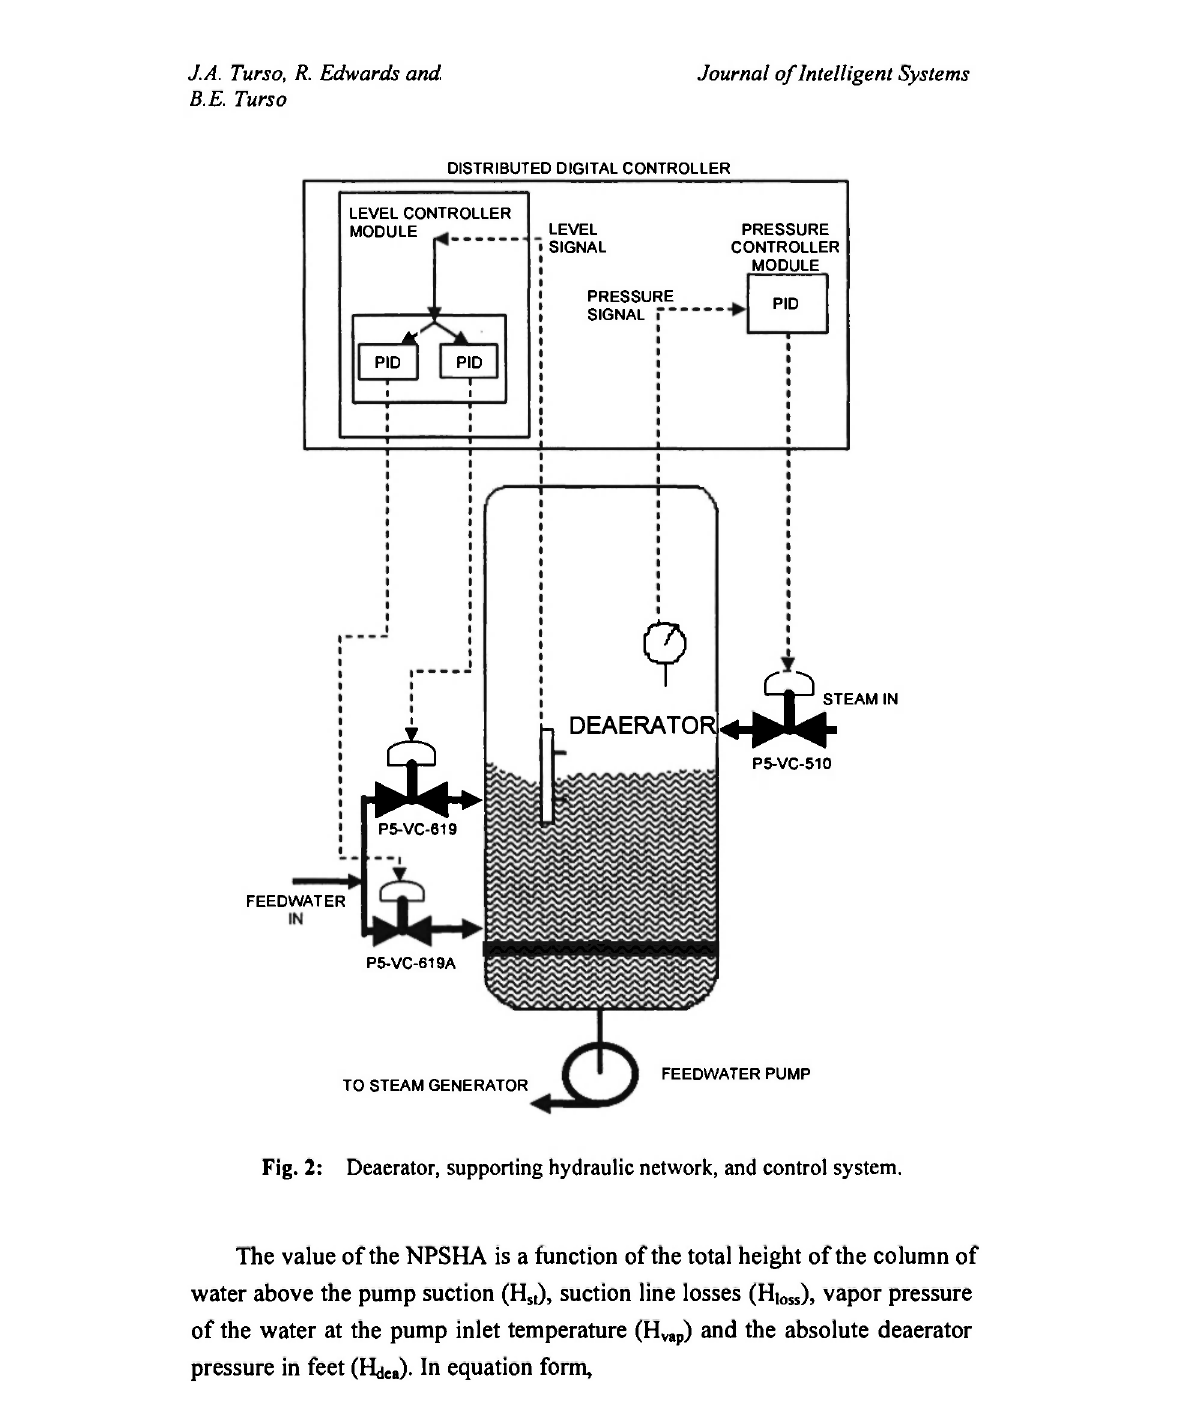
The value of the NPSHA is a function of the total height of the column of water above the pump suction (H sl ), suction line losses (Hi oss ), vapor pressure of the water at the pump inlet temperature (H vap ) and the absolute deaerator pressure in feet (H<j ea ). In equation form,